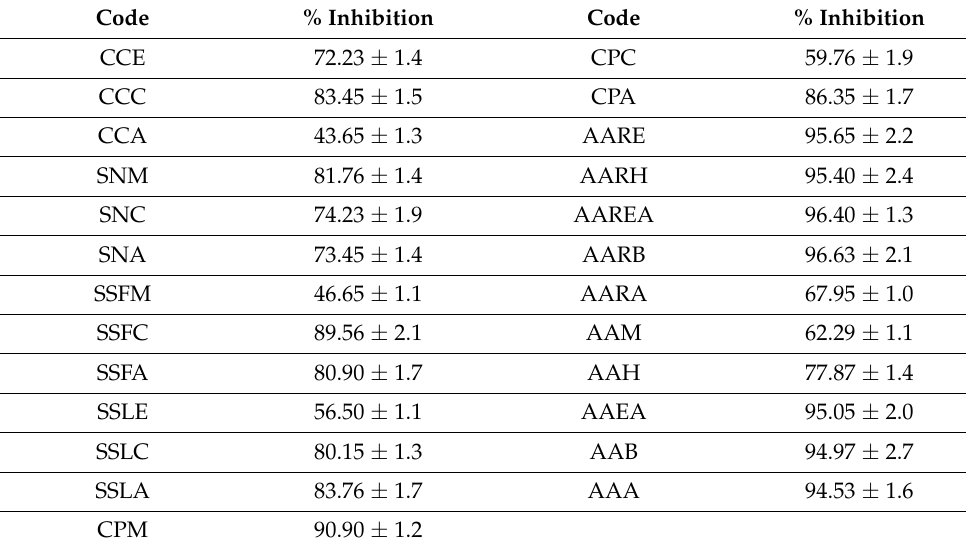
Table 7. Anti-diabetic activity of plant extracts. Code % Inhibition